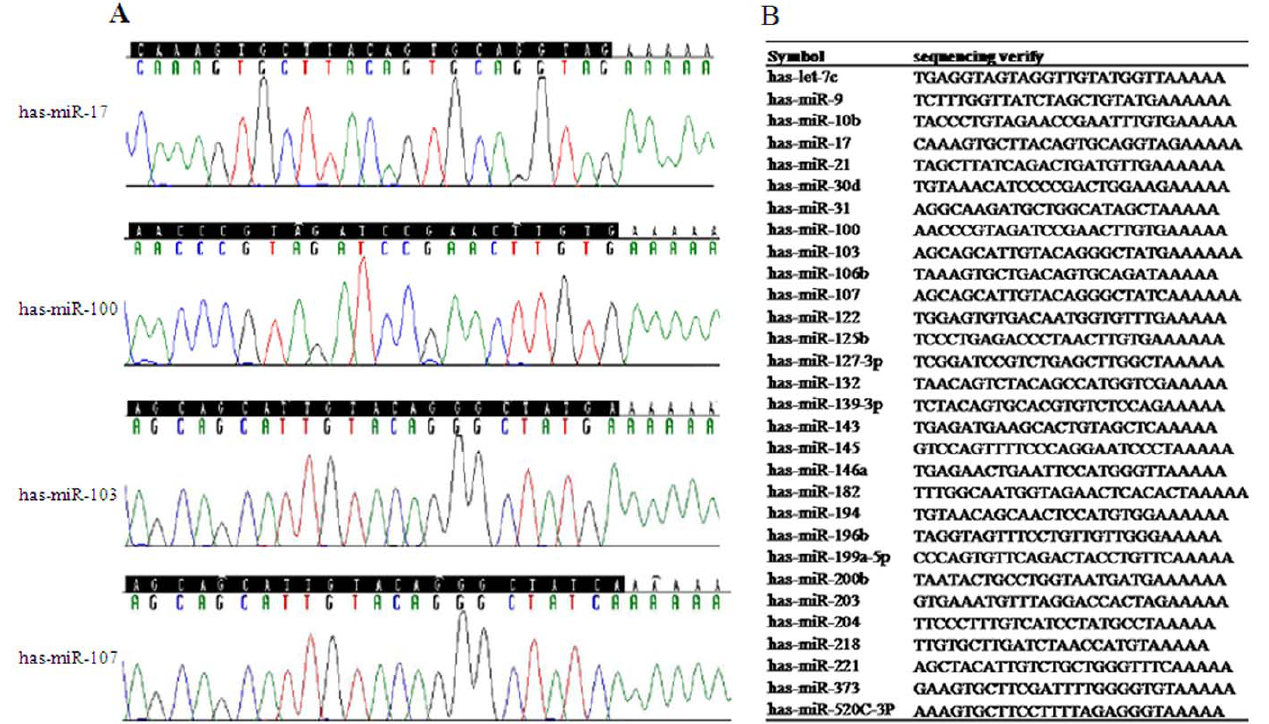
Figure 2. All PCR amplification products were confirmed by sequencing. (A): representative chromas of the 30 miRNAs. (B): the result of sequencing for each miRNAs.